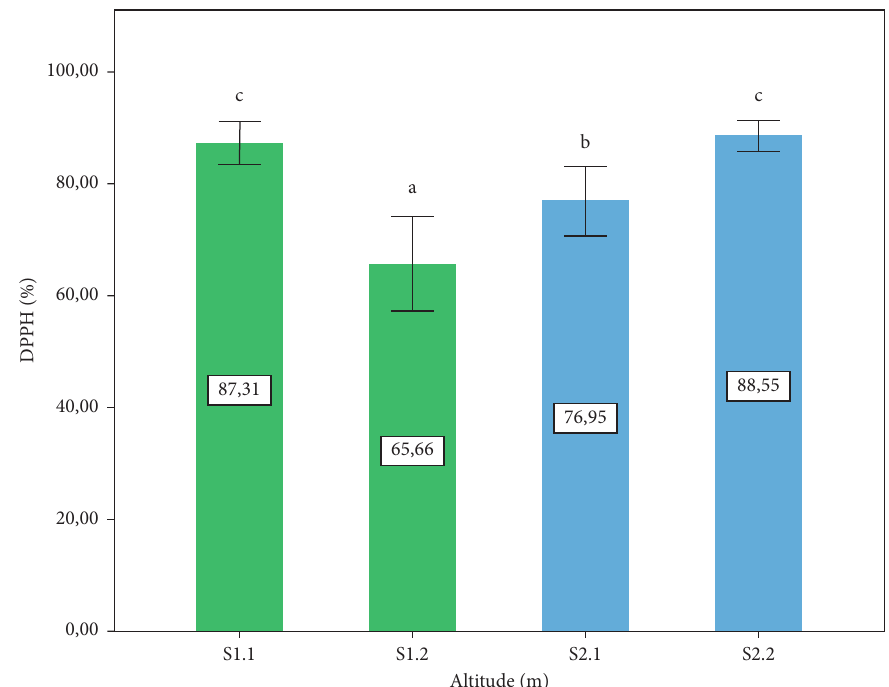
Figure 7: P. lentiscus L. leaves’ extract on DPPH (%) activity at different altitudes. Data are means of three replicates. Vertical bars represent the standard deviation of the mean. Values not sharing a common letter indicate a significant difference at p ≤ 0 . 05, based on the SNK test. DPPH: